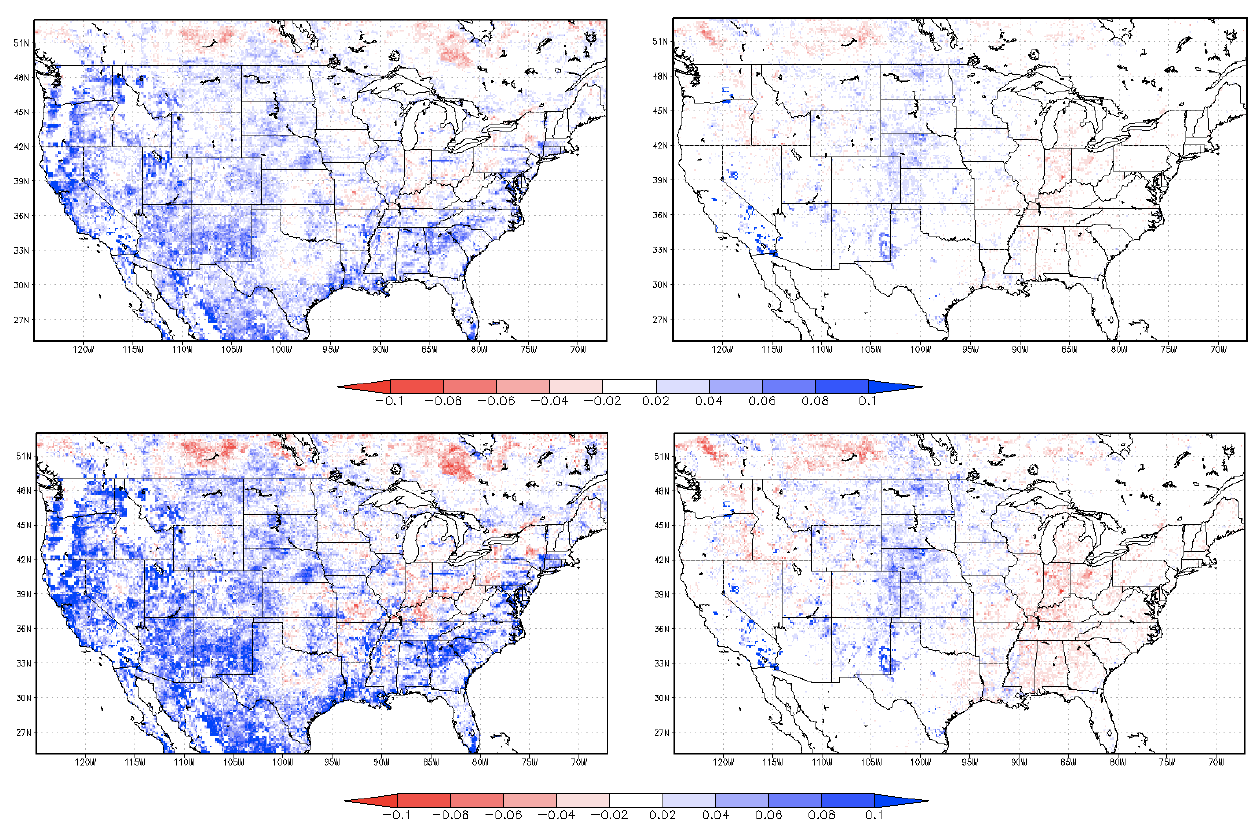
Fig. 7. Changes in Metric Entropy (top row) and Information gain (bottom row) from the assimilation of NASA AMSR-E (left column) and LPRM AMSR-E (right column) retrievals